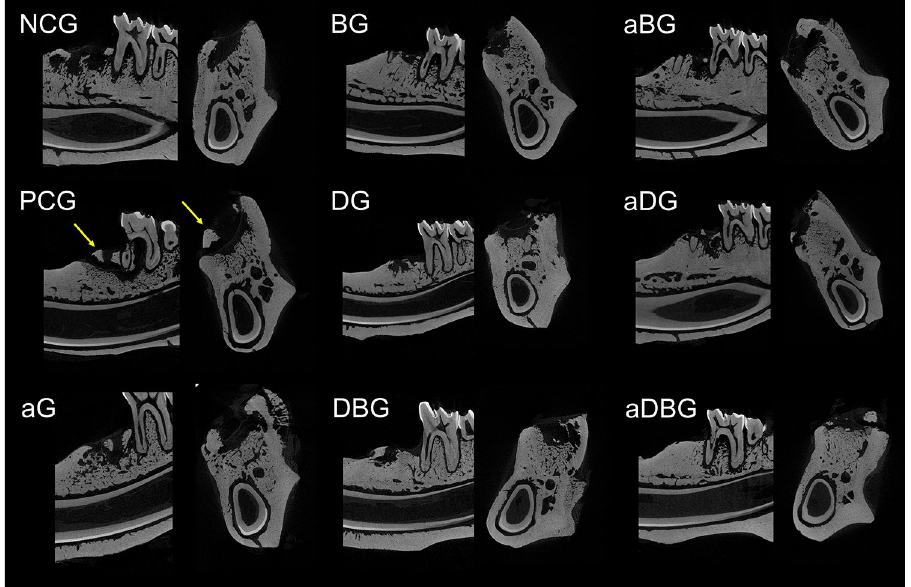
Figure 3. Representative images from the micro-CT. Each group is identified by its initials, followed by the sagittal and coronal section in the alveolar region of the distal root of the mandibular first molar. Yellow arrows demonstrate bone